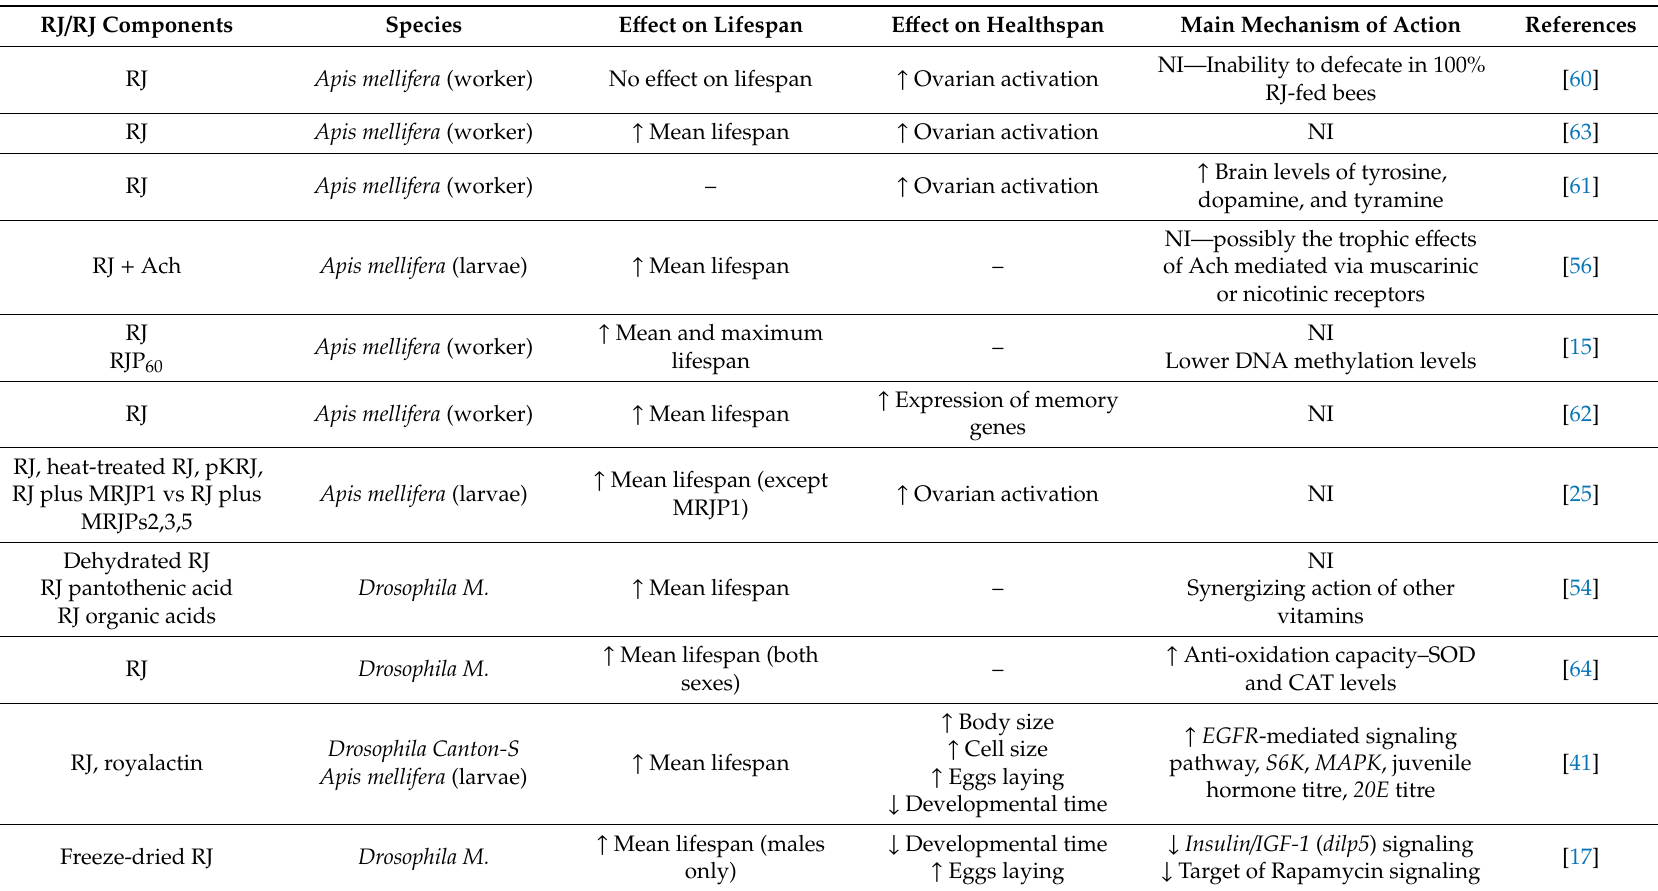
Table 1. E ff ect of Royal jelly and its components on lifespan and healthspan in di ff erent